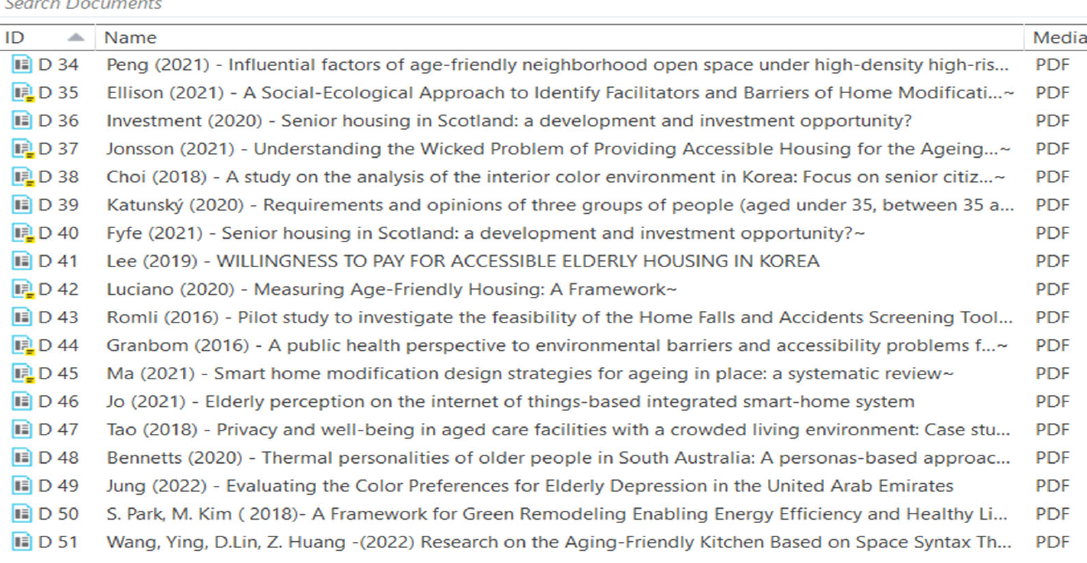
Figure 1. Inclusion and exclusion criteria using thematic review method. Table 2. Search strings from Web of Science and Scopus.